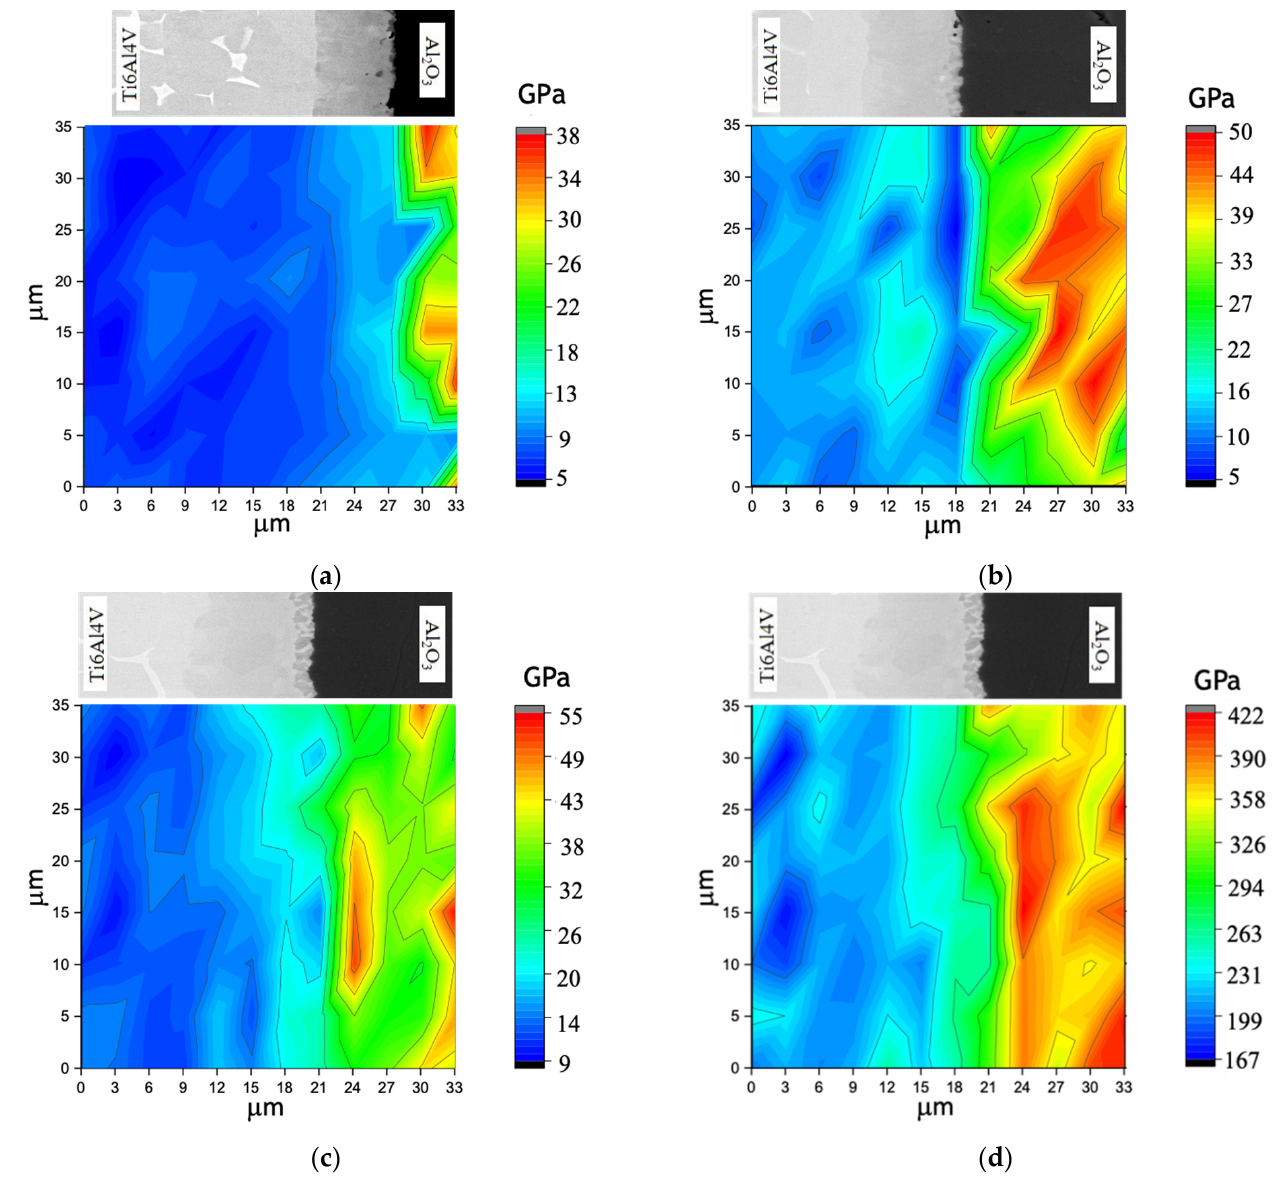
Figure 8. ( a – c ) Hardness maps of the joints processed at 950 °C for 60 min, 1000 °C for 10 min, and 1000 °C for 60 min, respectively, and ( d ) reduced Young’s modulus map across the joint processed at 1000 °C for 60 min.